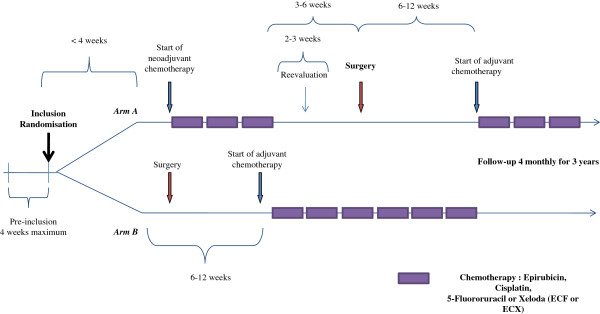
Therapeutic scheme for the protocol.